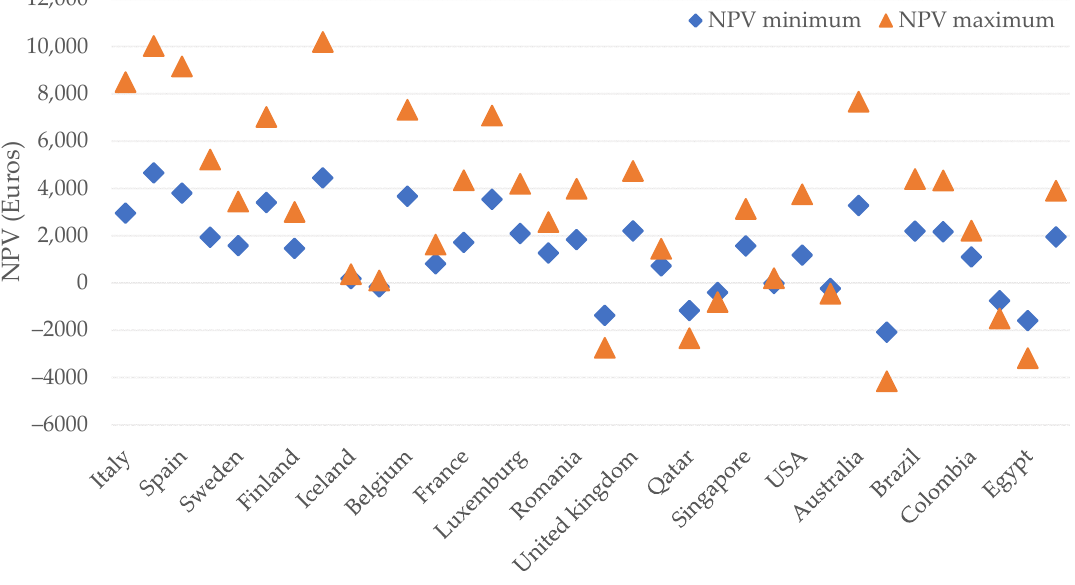
Figure 25. Country-wise NPV potential per unit collector area for financing model 2.